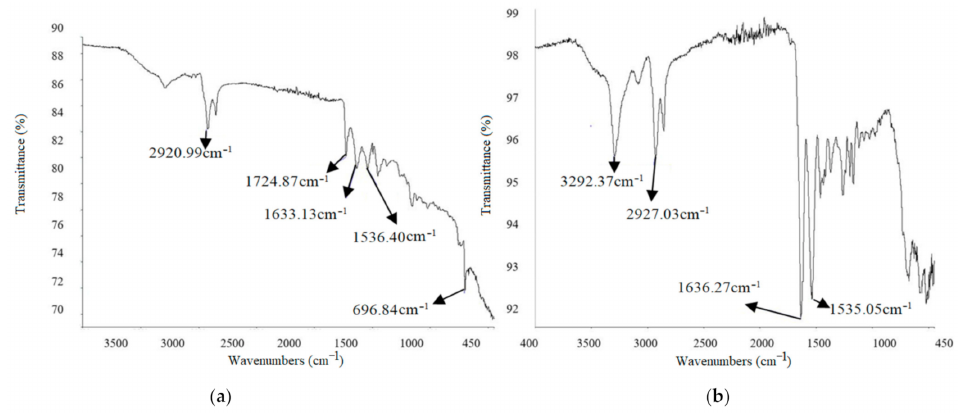
Figure 15. FTIR graphs of Nylon composites: ( a ) B2 and ( b ) C3 . FTIR for ABS with different ratios of copper particles are shown in Figures 16 and 17.